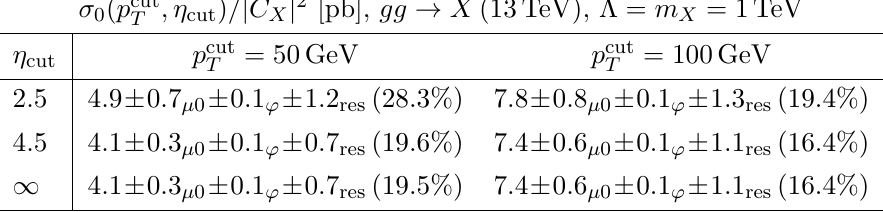
X for m X = 1 TeV at NLL 0 +NLO for di(cid:11)erent values of p cut !